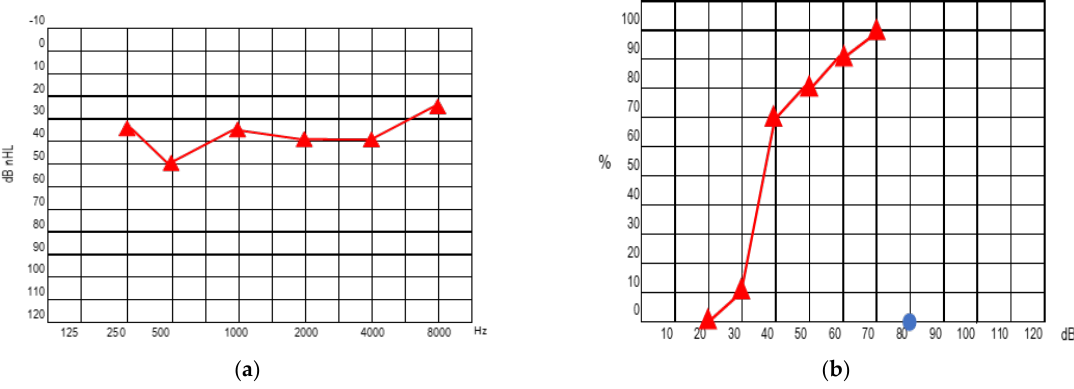
Figure 4. Right ear with CI: pure tone audiometry ( a ) and speech audiometry ( b ) at the last follow- up.